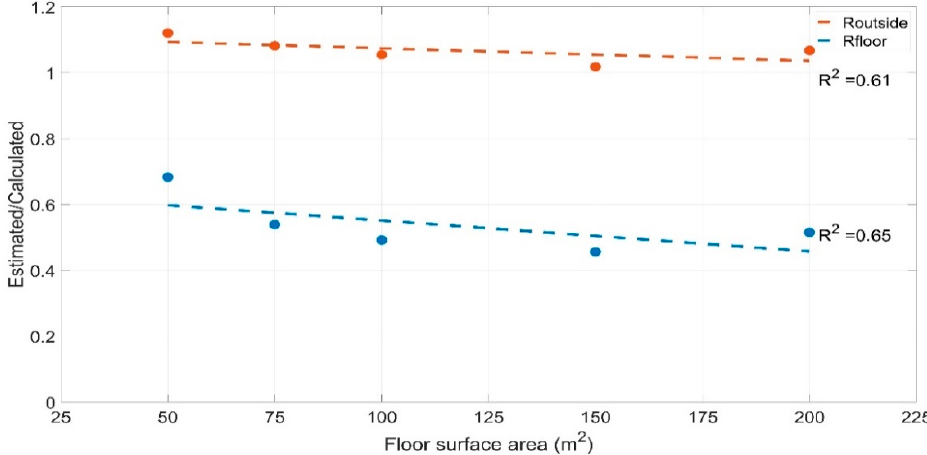
Figure 8. Estimated/calculated ratio of resistances for different floor surface areas in x-2-15-0 light-structured buildings.